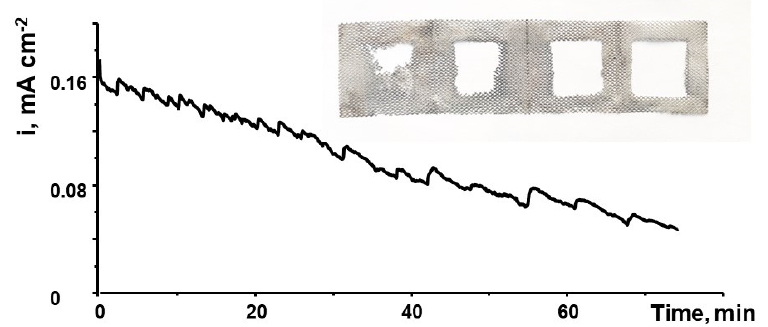
Figure 2. Chronoaperometric measurements at E = 1.4 V for the Al/NaBrO 3 cell at 50 °C. The other conditions are the same as those in Figure 1. The inset shows a photo of the unfolded electrode removed from the cell after measurements.